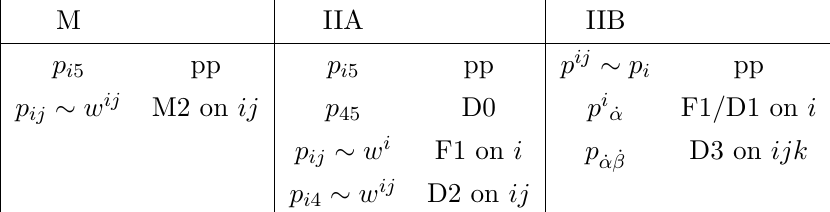
Table 2 . Totally wrapped branes (particles): p ab .